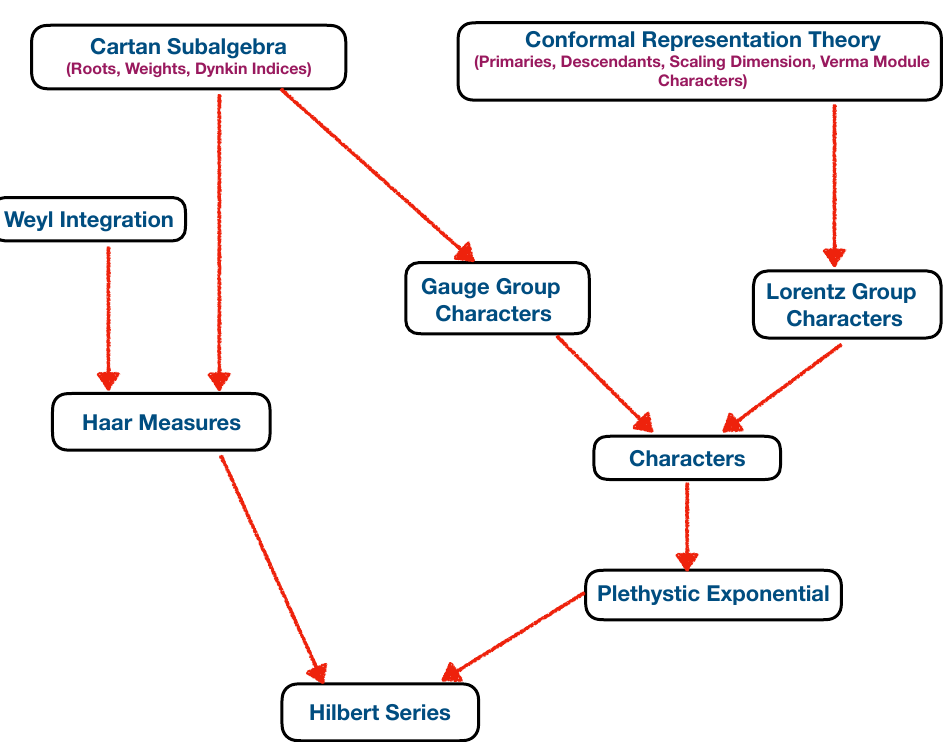
Figure 1. Flow chart depicting the Hilbert Series